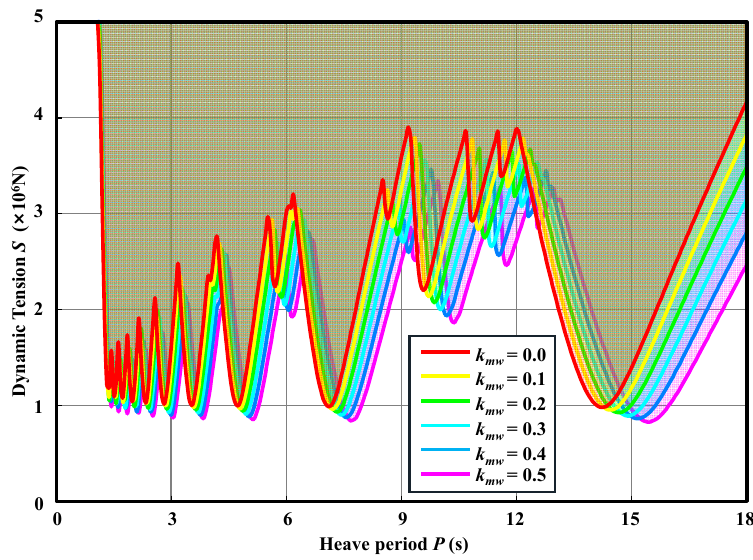
Figure 11. Parametric instability charts of risers with different wet-weight coefficients.